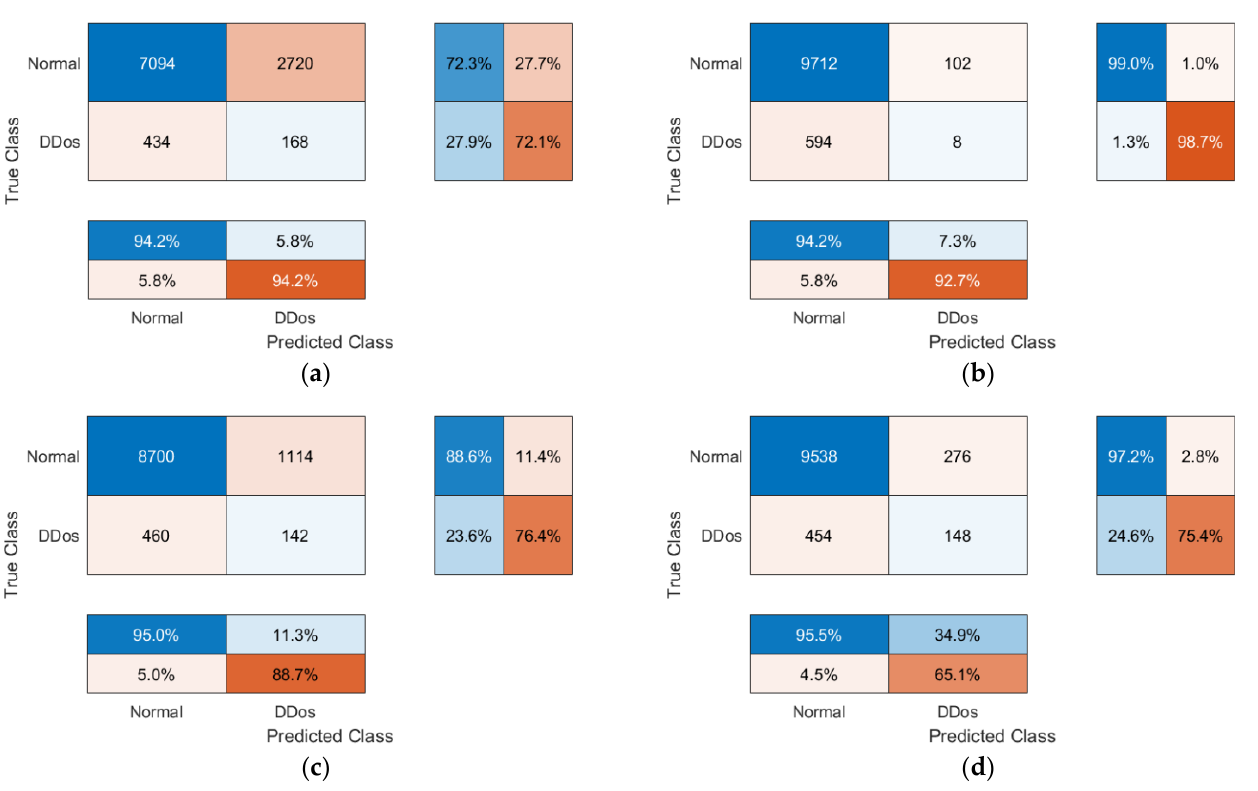
Figure 12. Confusion matrices visualizing the performance of the FTL method: ( a ) for local Model1; ( b ) for local Model2; ( c ) for local Model3; ( d ) for local Model4.